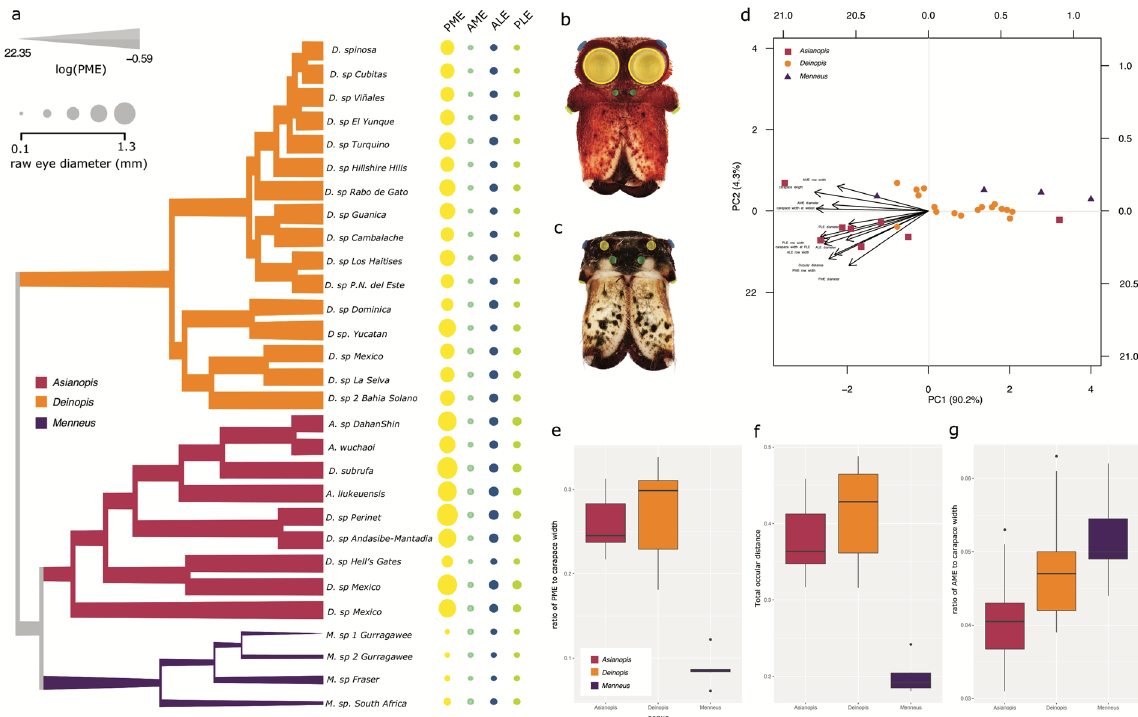
Figure 5. Summary of eye size data. ( a ) MCC phylogeny with branch width representing the log of PME to carapace ratio. The size of the dots represents raw eye diameter (mm) and are colored by eye type: PME (yellow), AME (blueish green), PLE (blue), ALE (yellowish green). ( b ) A. subrufa and ( c ) M. sp Gurragawee with eyes colored by type- also represented in dot phylogeny. ( d ) pPCA biplot of deinopid genus clusters (n = 29) based on carapace and eye dimensions. Clades, boxplots, and pPCA are colored by genus: Asianopis (magenta), Deinopis (orange); Menneus (purple). Boxplots represent ( e ) PME diameter scaled to carapace width, ( f ) total ocular distance, and ( g ) AME scaled to carapace